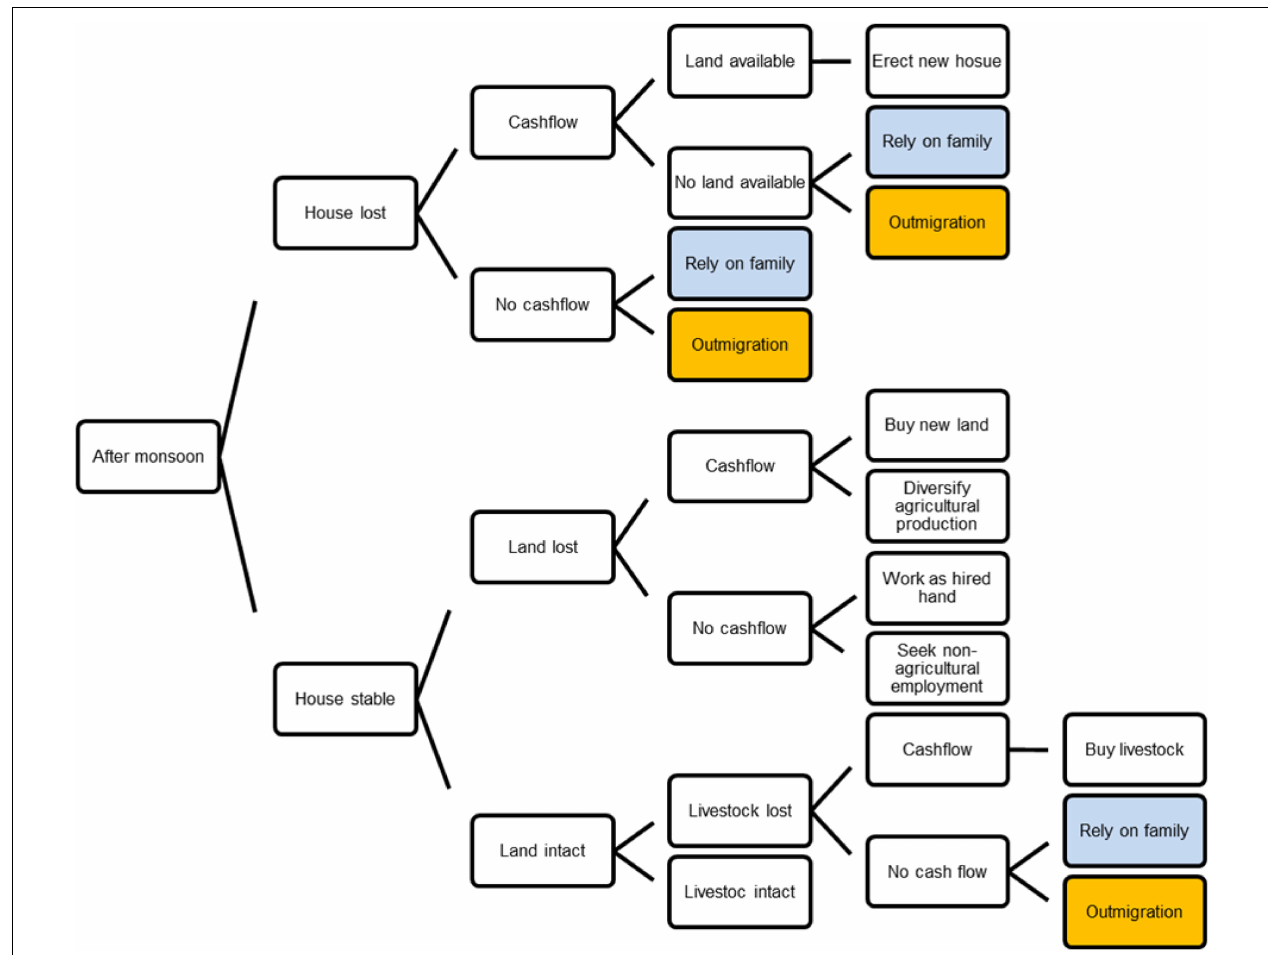
FIGURE 5 | Decision making